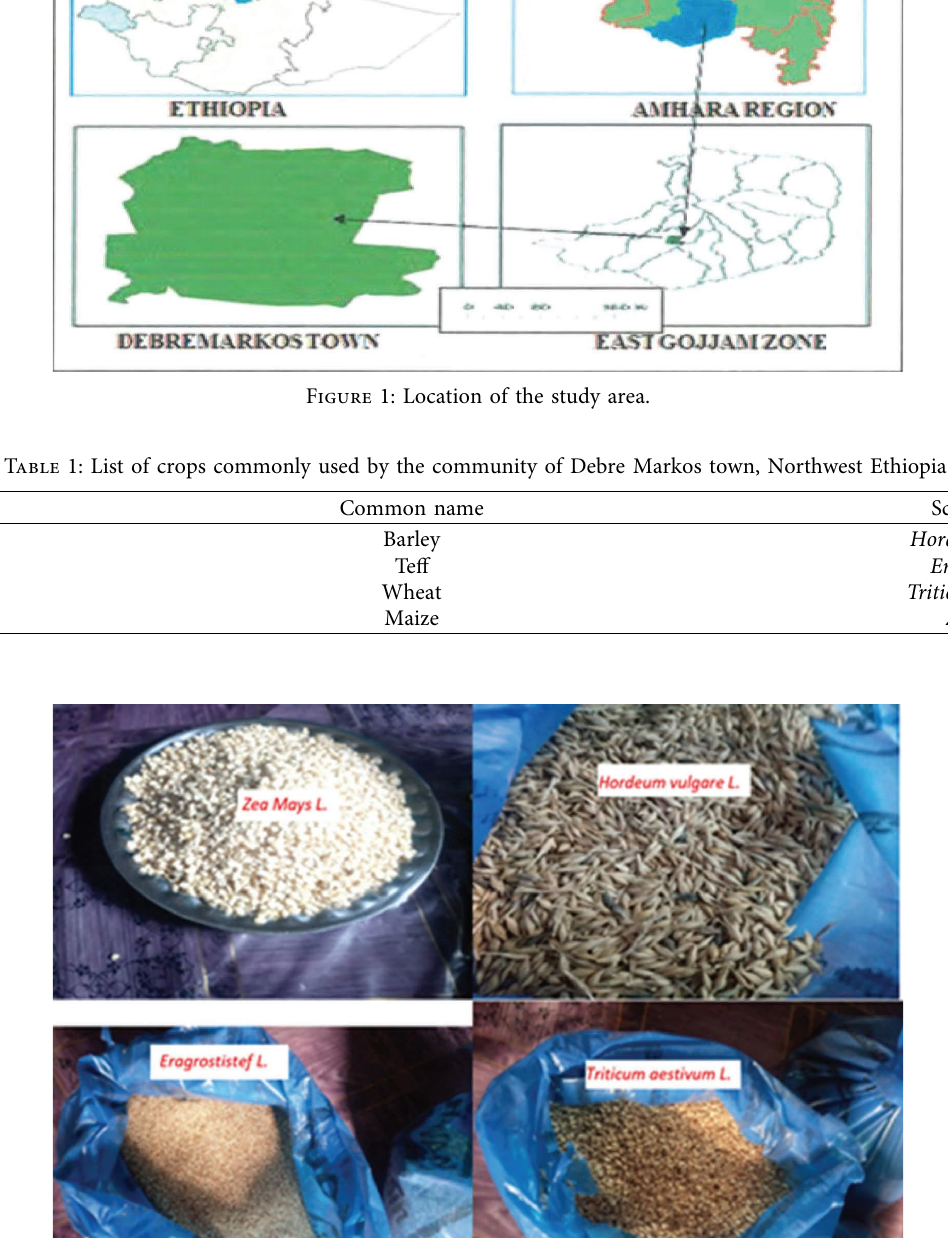
Figure 2: List of crops commonly used by the community of Debre Markos town, Northwest